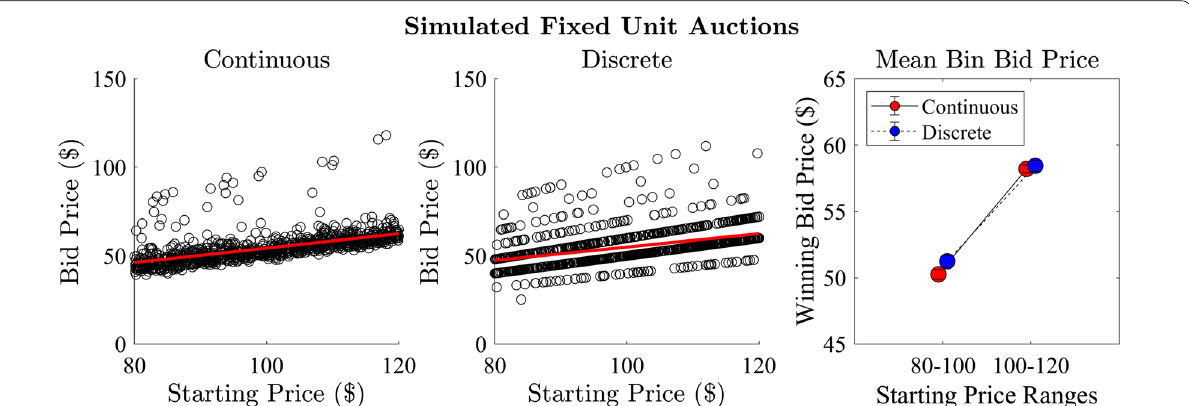
Fig. 15 Positive relationship between auction starting price and winning bid for continuous (left) and discrete (middle) conditions in model simulated Dutch auction group bidding. Mean bid price across low and high auction start prices (right) in the model-simulated data displays the same increase pattern in bid prices as the empirical data (cf. Fig.